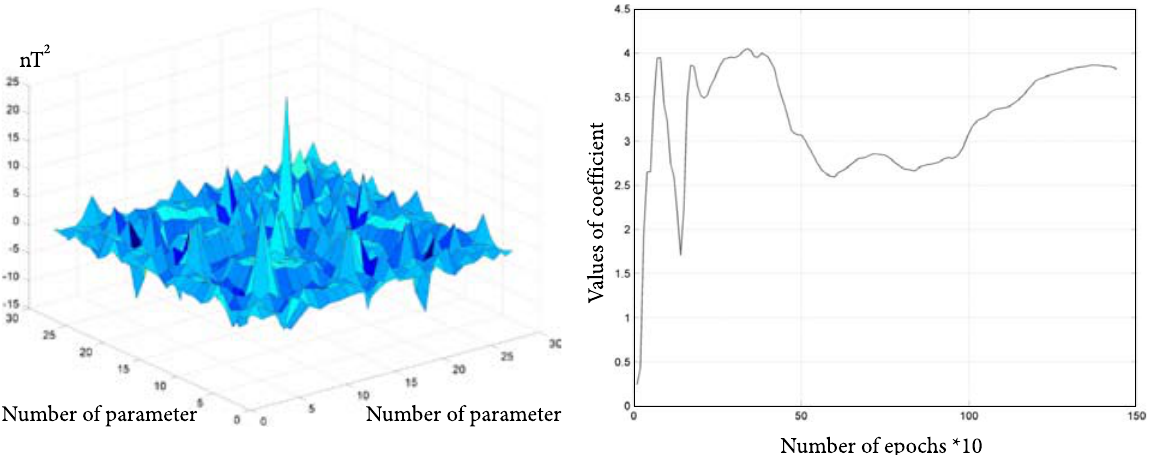
Fig. 1. Graphical view of covariation matrix of F ( t ) vectors from Belsk2 and Hel30 observatories